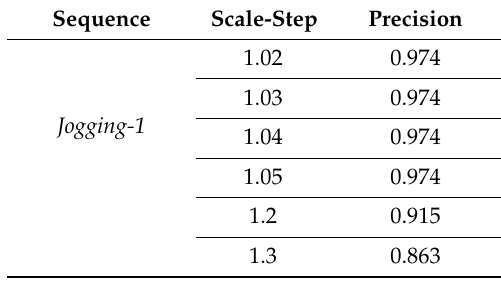
Table 2. Different scale-step values and their corresponding precision.